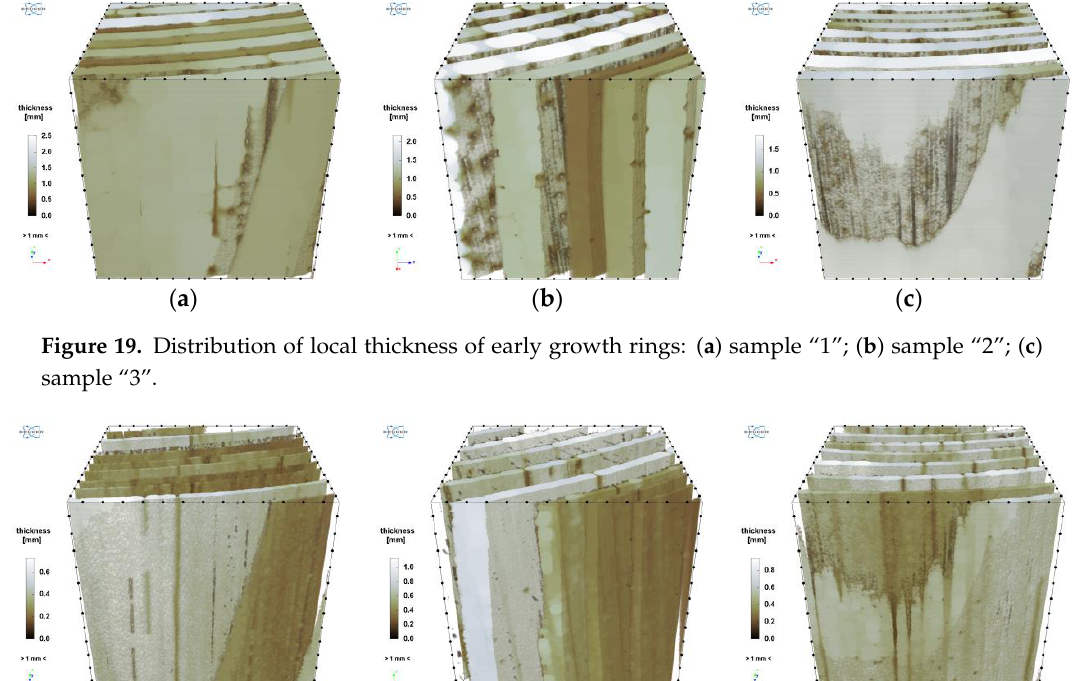
Table 12. Selected results for di ff erent